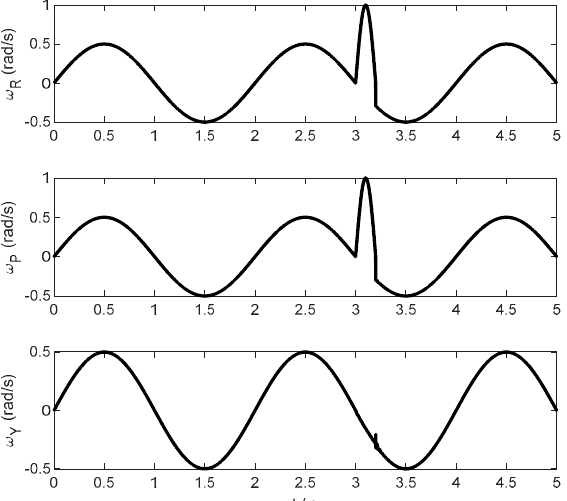
Figure 11. The angular velocity with external disturbance of the platform in the simulation of attitude locking tracking trajectory.